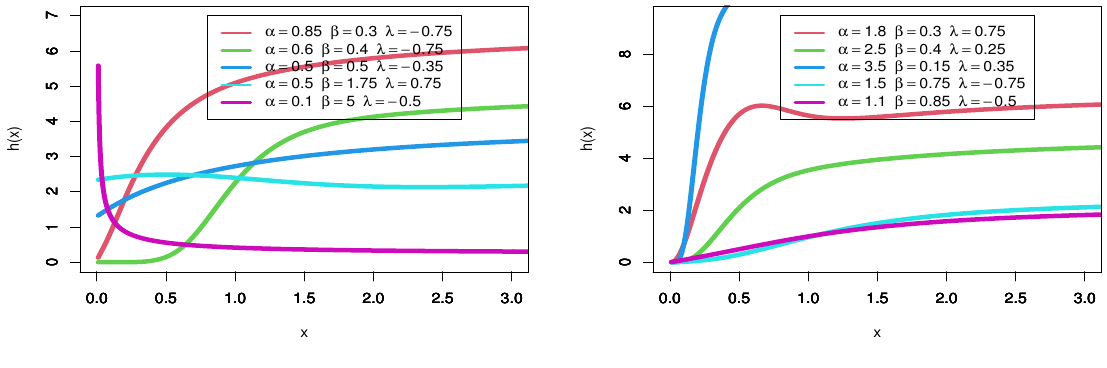
Figure 2. hrf of TT L LBE